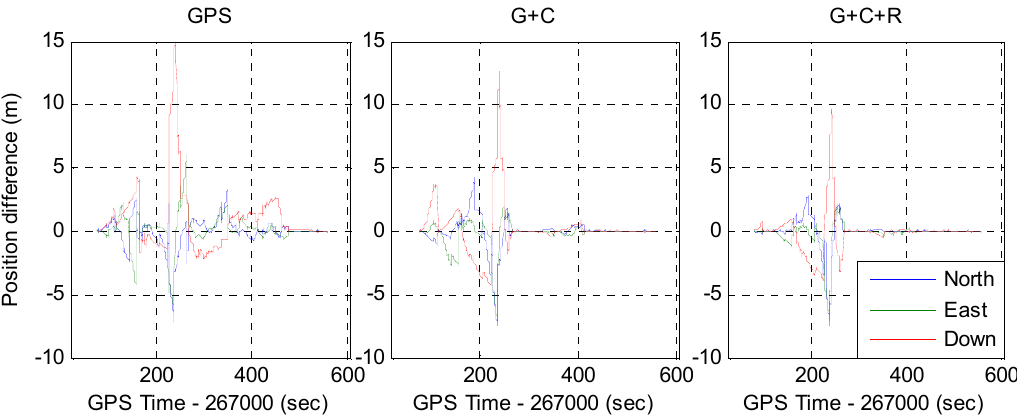
Figure 9. Position difference of the tightly coupled RTK/INS integration with respect to the reference for the GPS, GPS + BDS (G + C), and GPS + BDS + GLONASS (G + C + R) systems.